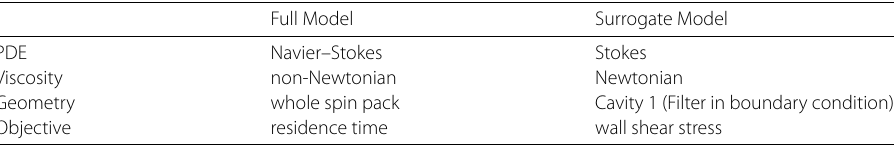
Table 1 Comparison between Full and Surrogate